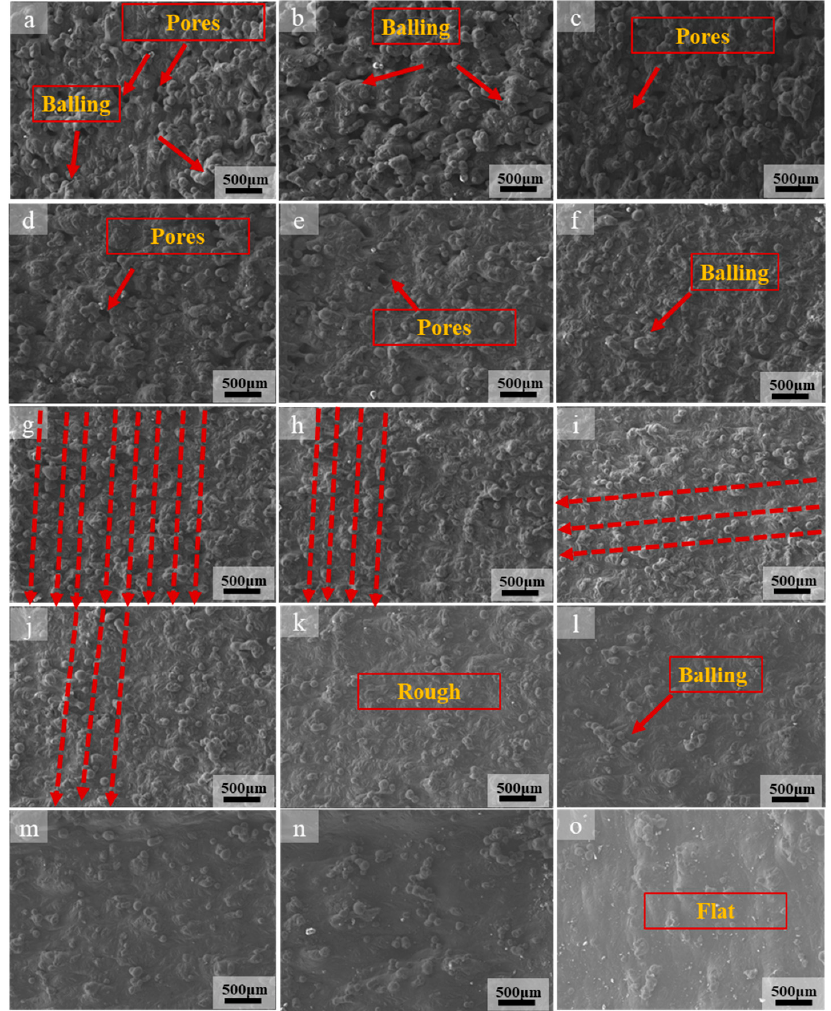
Figure 4. Low-magnification SEM image of surface morphology of SLMed AZ61 magnesium alloy under different scanning speeds: ( a ) 950 mm/s, ( b ) 900 mm/s, ( c ) 850 mm/s, ( d ) 800 mm/s, ( e ) 750 mm/s, ( f ) 700 mm/s, ( g ) 650 mm/s, ( h ) 600 mm/s, ( i ) 550 mm/s, ( j ) 500 mm/s, ( k ) 450 mm/s, ( l ) 400 mm/s, ( m ) 350 mm/s, ( n ) 300 mm/s, ( o ) 250 mm/s.